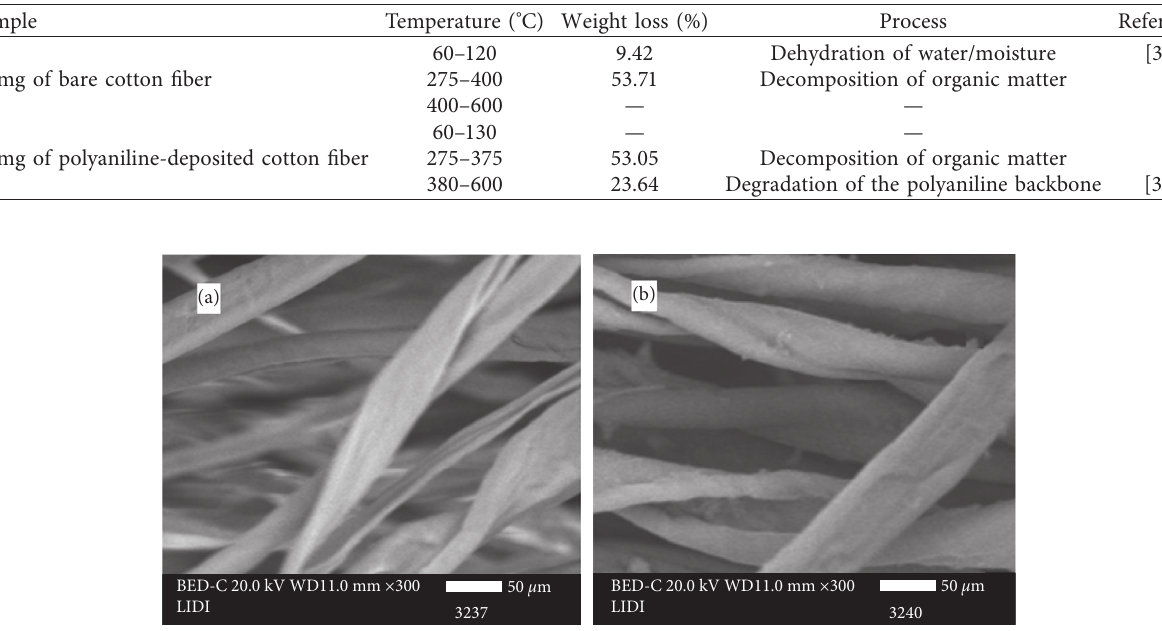
Figure 5: SEM micrographs of (a) bare cotton fibers and (b) polyaniline-deposited cotton fibers.